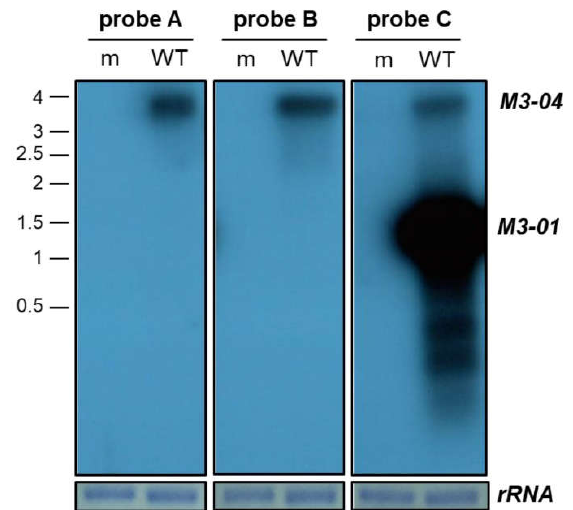
Figure 2. Northern blot validation of M3-04 transcript. RNA was harvested from NIH 3T12 fibroblasts at 18 hours from cells that were mock-infected (m), or infected with wild-type MHV68 (WT) at MOI 5. Three different strand-specific probes were used on northern blots to detect transcripts expressed within the M3/M2 locus. Probes A, B, and C detected an approximately 3.9 kb transcript, corresponding to M3-04 . Probe C also detected an approximately 1.6 kb transcript, corresponding to M3-01 , as well as two smaller RNAs. An 18S ribosomal RNA (rRNA) on the methylene blue stained membrane is shown as the loading control.